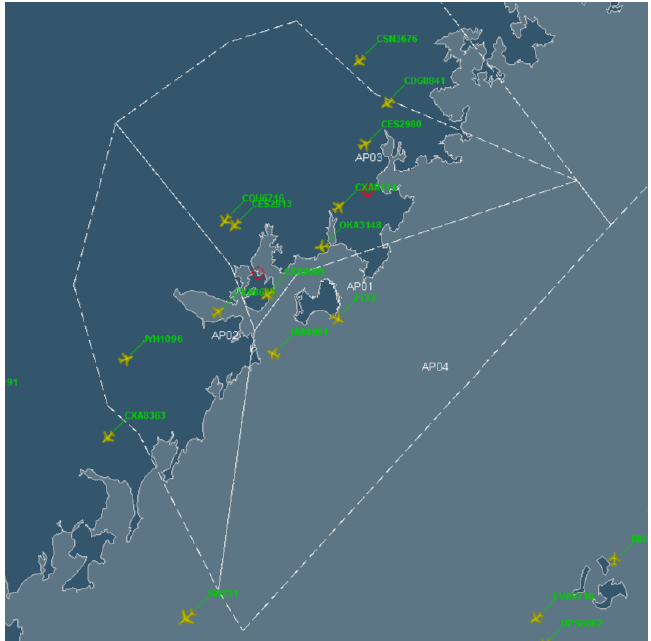
Figure 12. Radar map of Xiamen Gaoqi Airport airspace. Table 1. Aircraft node coordinates.